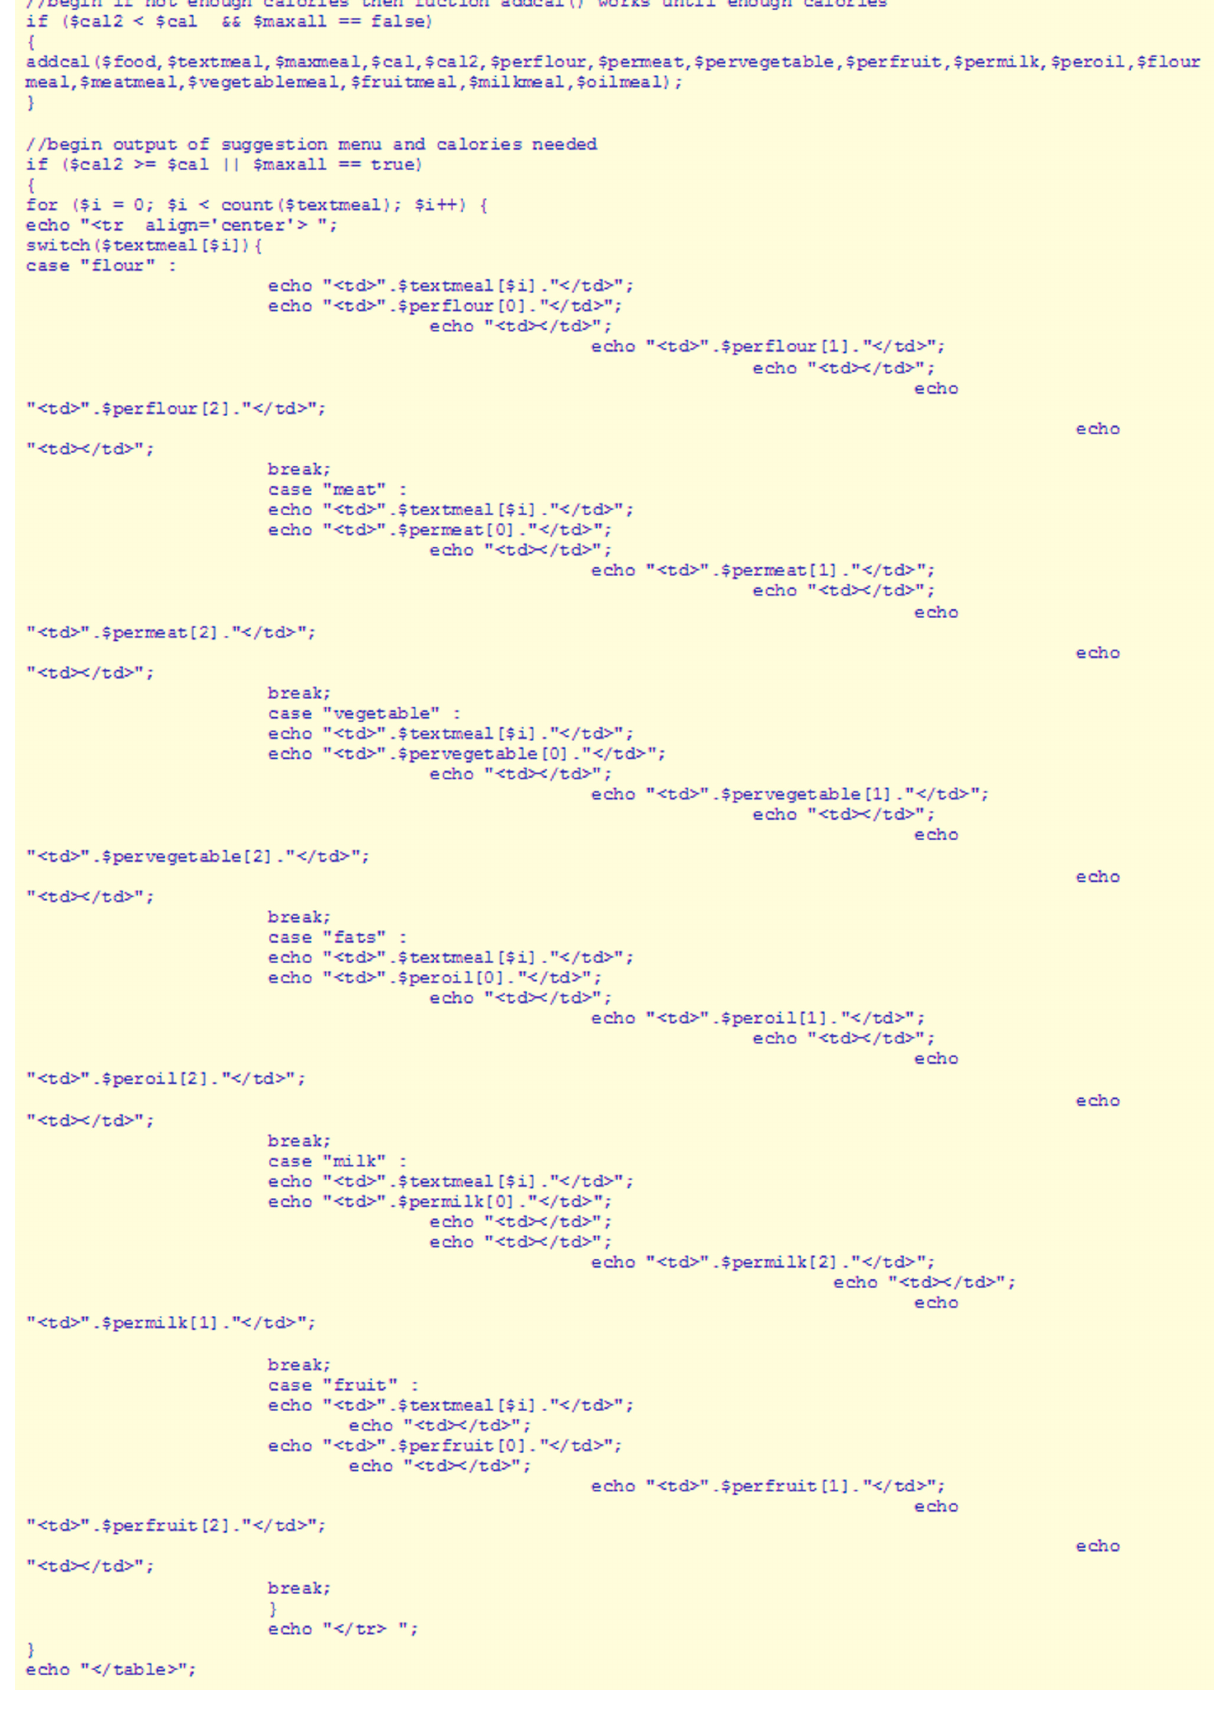
Figure 7. Code snippet showing the processing section for the output in FOODS—Diabetes